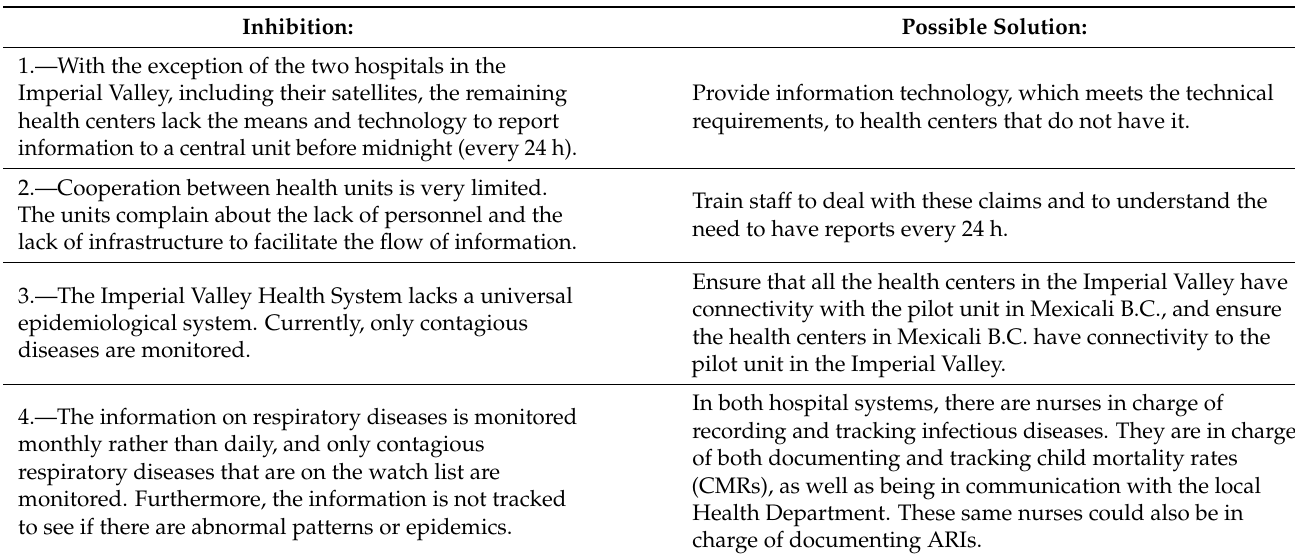
Table 3. Inhibitions and solutions for the daily recording of morbidity data for ARIs in the Impe- rial